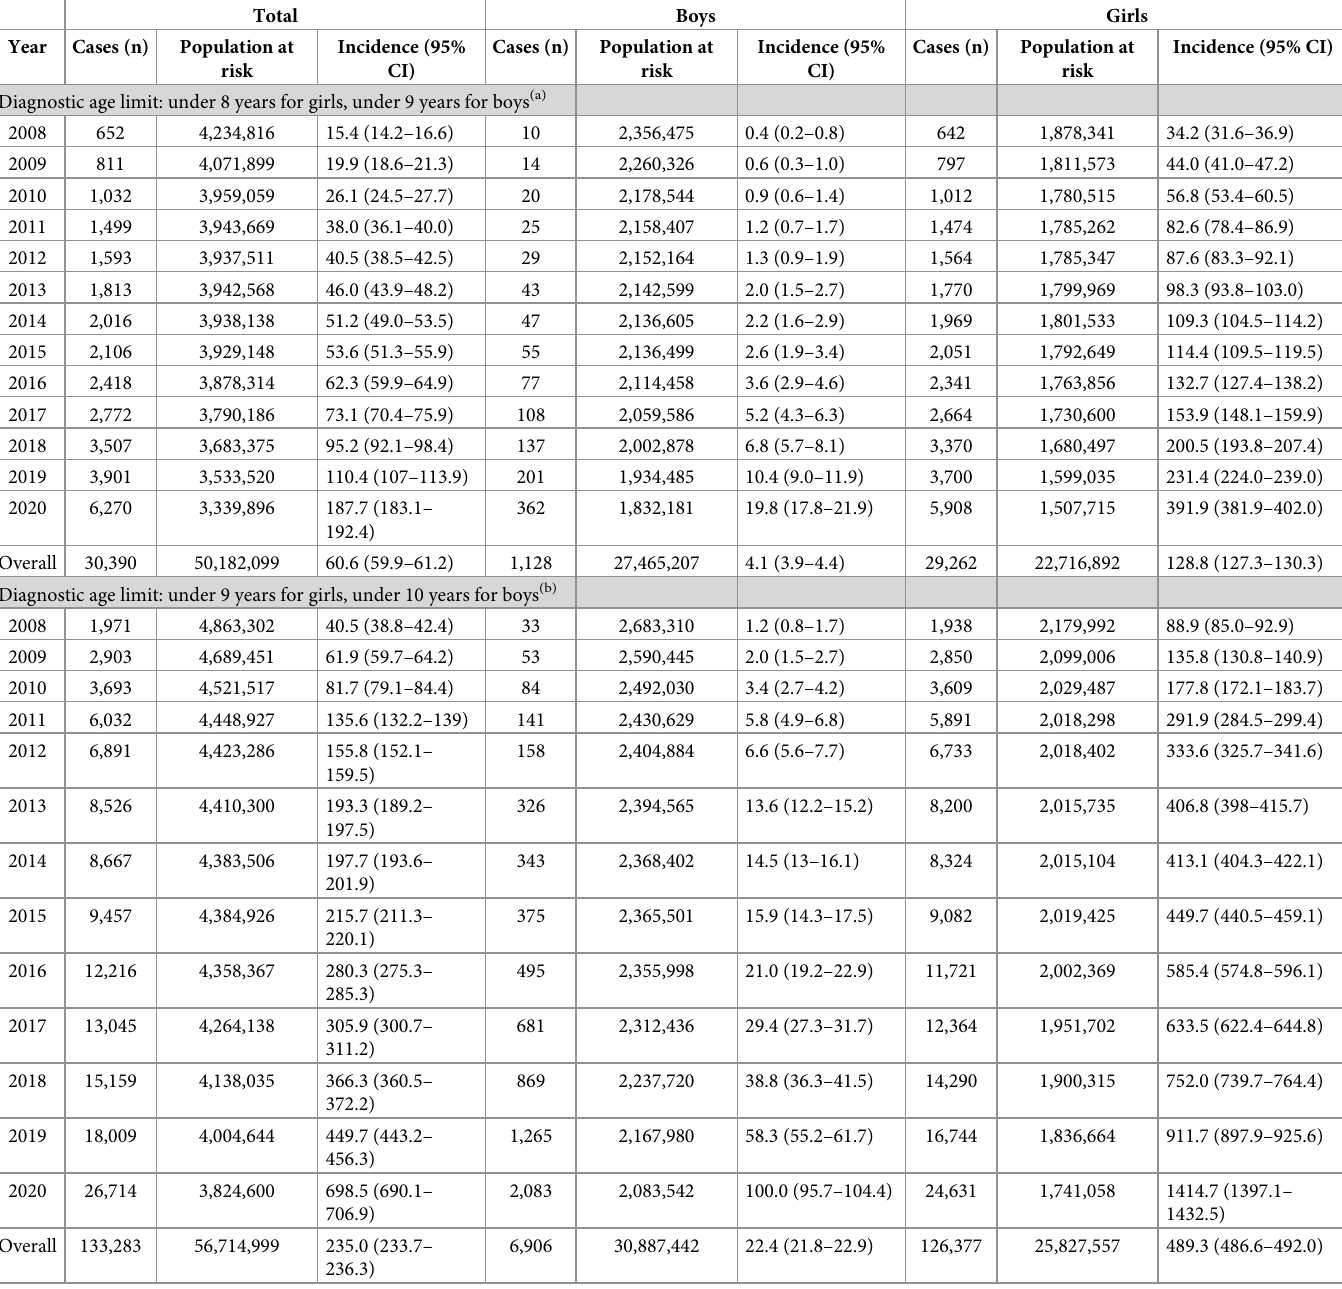
Table 1. The annual incidence (95% confidence interval) of central precocious puberty per calendar year. Total